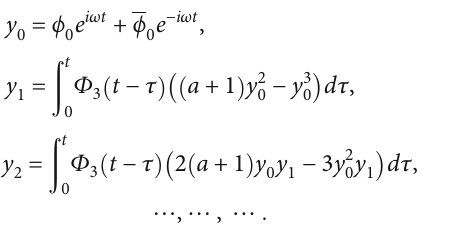
with c = 0 : 16 . (c) 2,4 ð 0 Þ = 0 : 01 , u ð 0 Þ = − 0 : 01 , 1 2